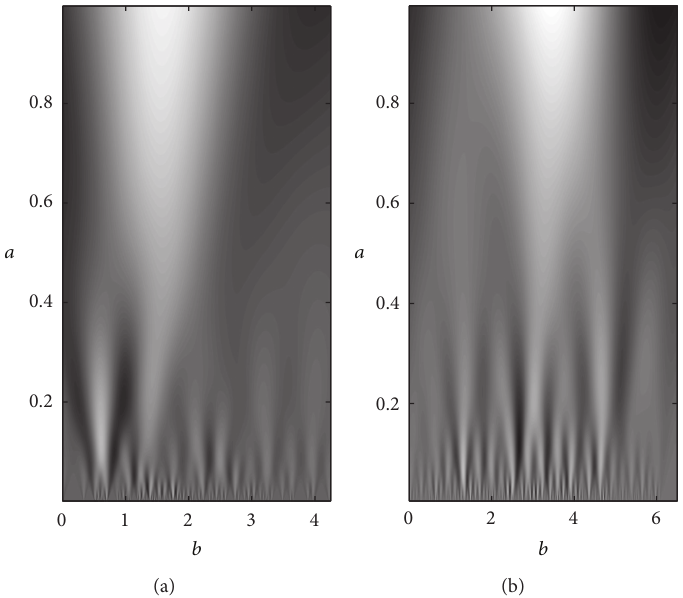
Figure 4: Wavelet pseudorapidity spectra for a single event (a) in 28 Si-Ag/Br interaction at 14.5AGeV: event multiplicity 146, and (b) in 32 S-Ag/Br interaction at 200AGeV: event multiplicity